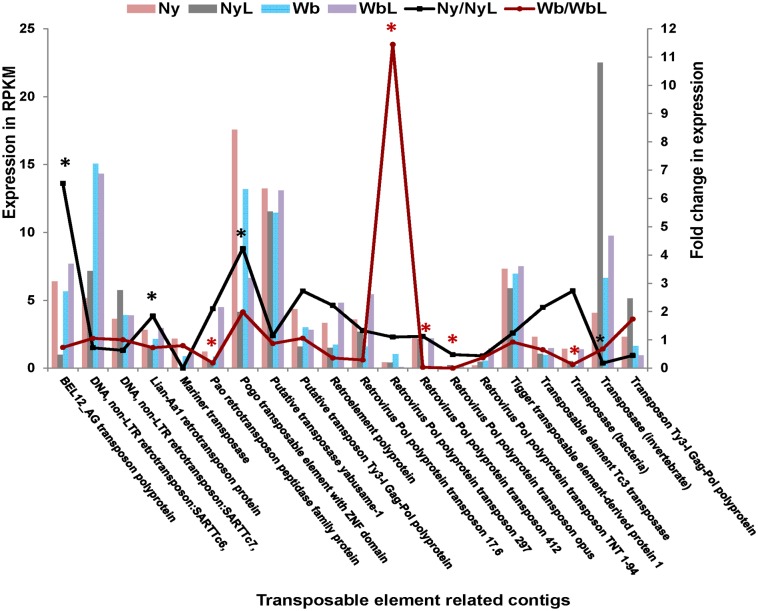
Transposon expression levels, in Ca. Liberibacter asiaticus (CLas) infected compared to uninfected Asian citrus psyllid (ACP) adults (Wb x WbL) and nymphs (Ny x NyL).The x- axis shows contigs representing different transposable element categories that were identified using the search terms, as described in the Methods section. Normalized expression in reads, per kilobase per million mapped reads (RPKM) of the transposable elements, is plotted on the primary y-axis for: uninfected nymphal instars (Ny-red bars), infected nymphal instars (NyL- grey bars), uninfected adults (Wb- blue bars), and infected adults (WbL-purple bars). The fold-change response to CLas infection is plotted on the secondary y- axis. The pairwise comparisons between infected and uninfected nymphal instars (NyL/Ny- Black line), and infected and uninfected adults (Wb/WbL-red line), are indicated by the line graphs. Significantly different levels of transcript expression (P>0.05) (*asterisk) are shown for infected and uninfected nymphs (black asterisk), and for infected and uninfected adults (red asterisk).